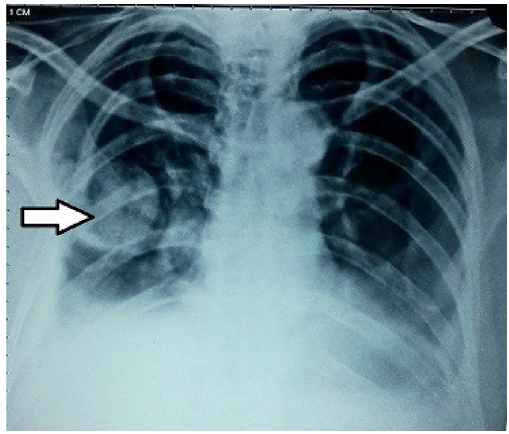
Figure 1. X-ray showing a well defined circular opacity in middle zone of right